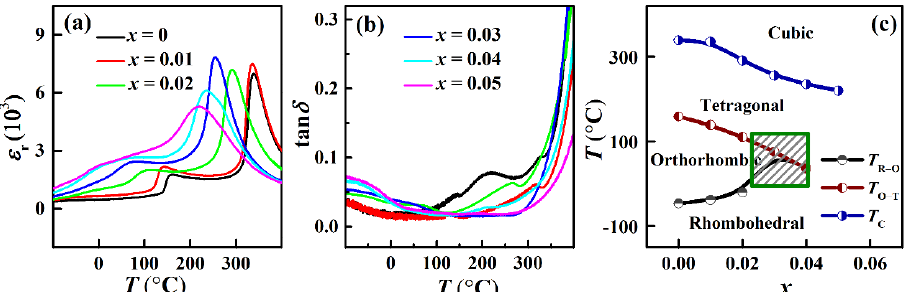
Fig. 3 Temperature dependence of (a)  r and (b) tan δ measured at 100 kHz of (0.99– x )KNNS–CZ– x BNH ceramics. (c) Phase diagram of (0.99– x )KNNS–CZ– x BNH